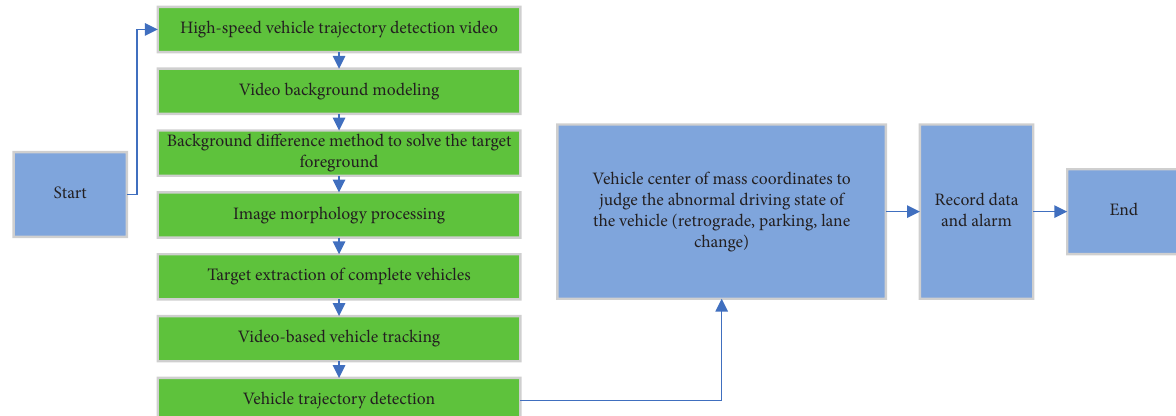
Figure 5: The software module flowchart of the highway vehicle driving state detection system integrated with the Internet of Things 5G.